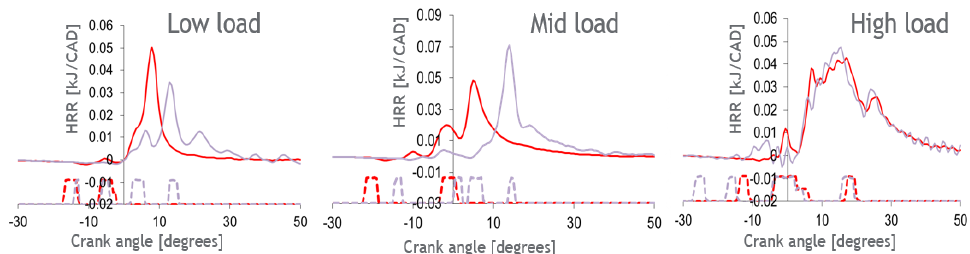
Figure 3. (Left ): Injected energy quantity versus energizing duration for different fuel injection pressures (MPa); ( Center ): liquid penetration for various air temperatures (air density 15 kg/m 3 ) at fuel injection pressure 160 MPa; ( Right ): vapor spray penetration for different fuel injection pressures and air temperature 900 K versus time — dual (solid lines) diesel – CN25 fuel (dashed lines) is a figure. Schemes follow the same formatting.